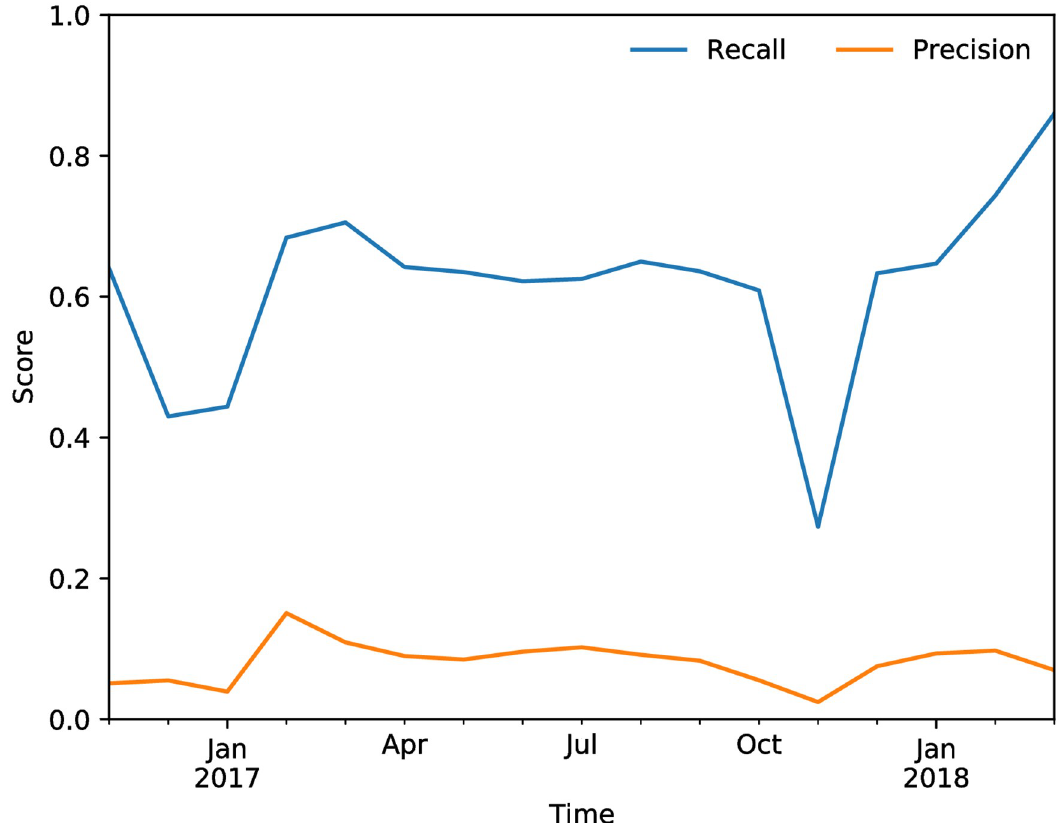
Fig 6. Recall@K and Precision@K for the random forest model based on firm features as a function of time. The average values for the score are R@K = 63.9%, P@K = 8.5%, F1 = 14.8%.